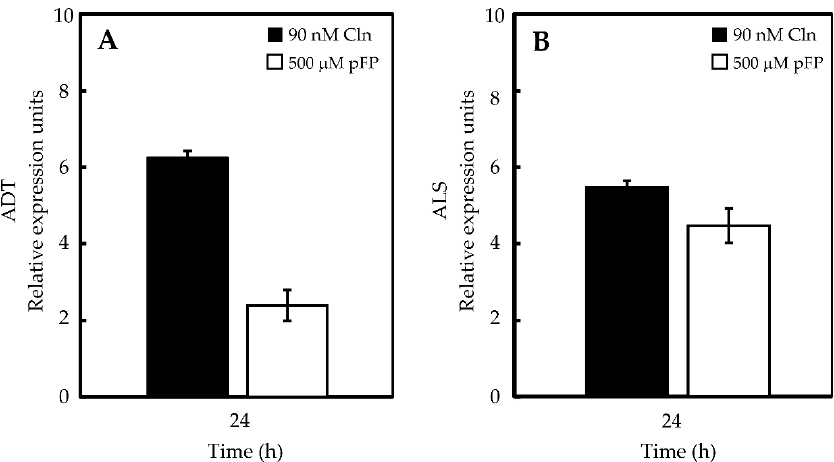
Figure 6. mRNA relative abundance of ADT ( A ) and ALS ( B ) in placentas maintained in vitro. Gene transcripts were quantified using the cycle threshold value (Ct), using actin as a reference. All together, these data suggest that CAP accumulation in isolated placentas responded to decreases in the internal availability of the required amino acids, suggesting that a coordinate mechanism channeling them towards CAP synthesis is operating.